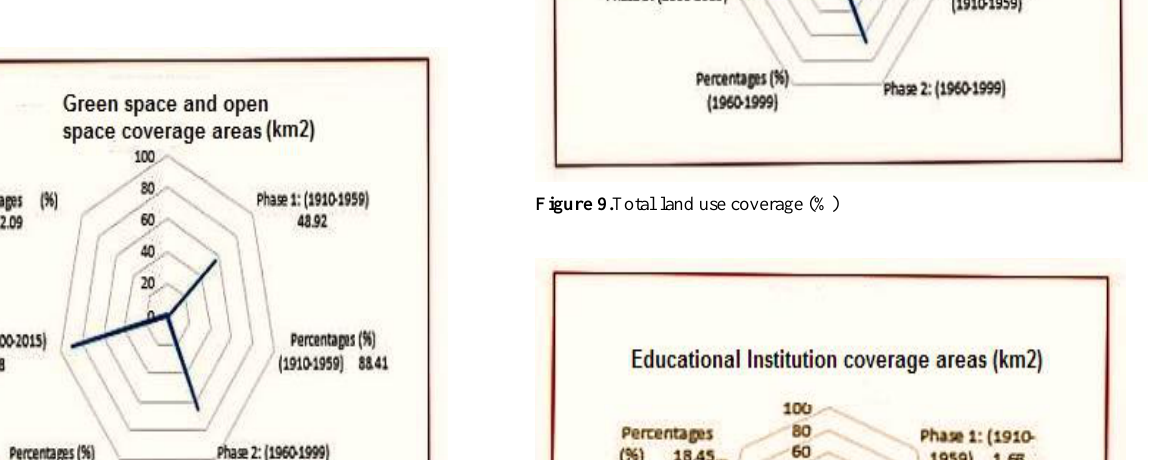
Figure 6. Land use coverage by the residential and Government structures